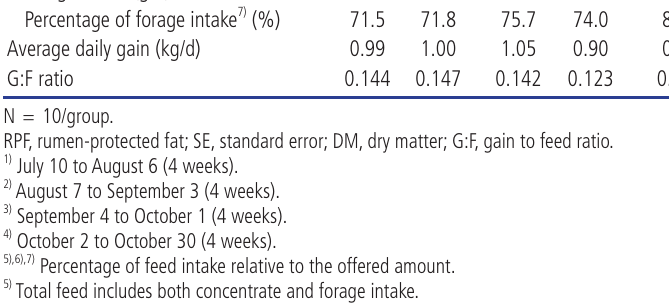
Percentage of total feed intake 5) (%) Concentrate intake (kg/d) Percentage of concentrate intake 6) (%)